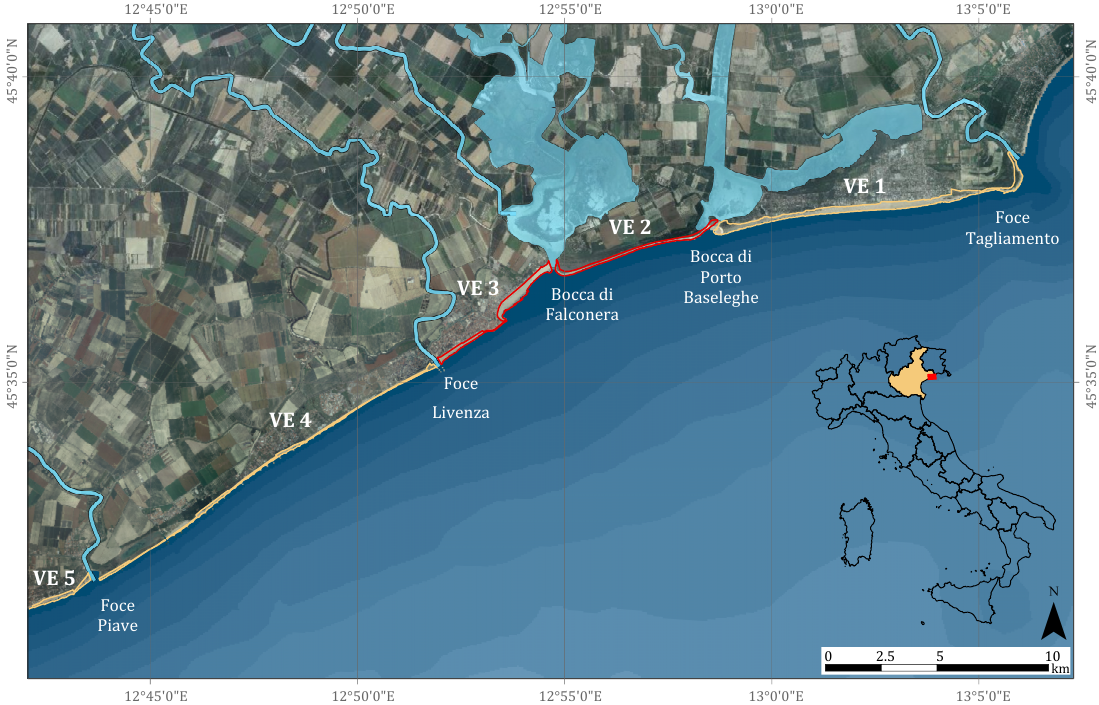
Figure 5. The northern part of the Venetian littoral and its subdivision into coastal cells: VE1, Bibione; VE2, Valle Vecchia; VE3, Caorle; VE4, Porto Santa Margherita–Duna Verde–Eraclea; VE5, Jesolo.